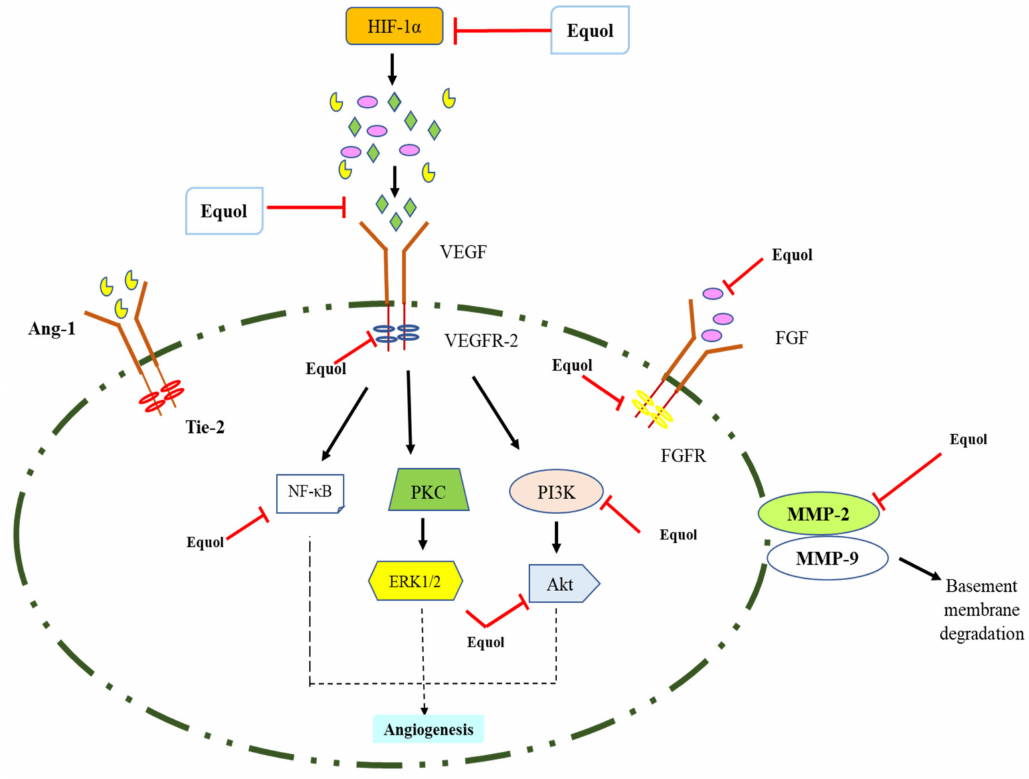
Figure 4. Major signaling pathways targeted by equol in angiogenesis and metastasis